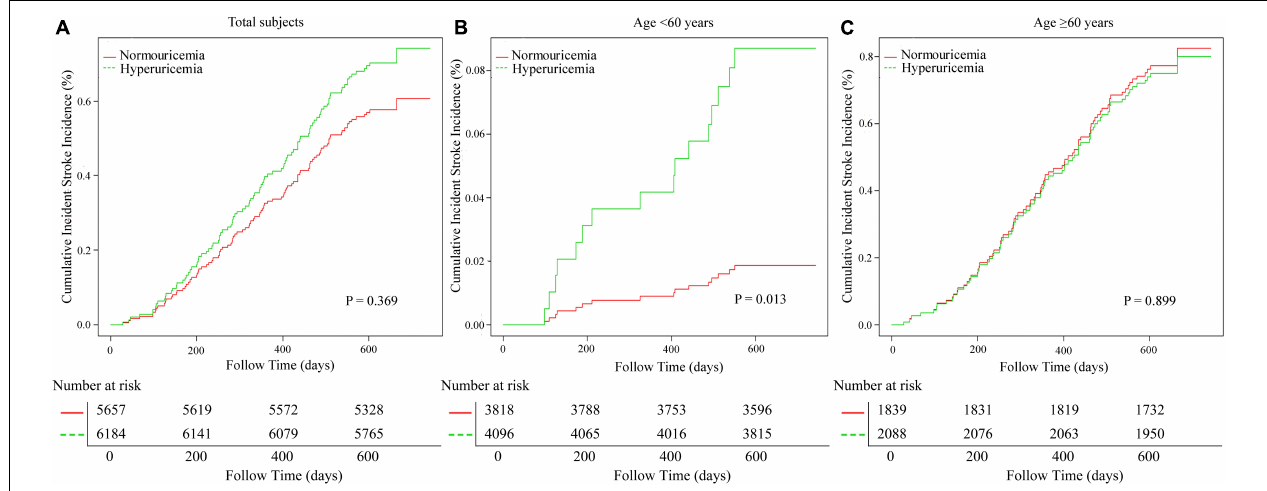
FIGURE 2 | The cumulative total first stroke risks in the study population. (A) Adjusted for age, sex, SBP, DBP, HR, BMI, smoking status, Hcy, TG, eGFR, ALT, and antiplatelet agents. (B) Adjusted for SBP, DBP, HR, WHR, TG, LDL-C, eGFR, ALT, lipid-lowering agents, and antiplatelet agents. (C) Adjusted for sex, SBP, DBP, HR, BMI, smoking and drinking status, Hcy, TG, HDL-C, LDL-C, AST, eGFR, and antiplatelet agents. eGFR, estimated glomerular filtration rate; SBP, systolic blood pressure; DBP, diastolic blood pressure; HR, heart rate, BMI, body mass index; Hcy, homocysteine; TG, total triglyceride; HDL-C, high-density lipoprotein cholesterol; LDL-C, low-density lipoprotein cholesterol; AST, aspartate aminotransferase; ALT, alanine